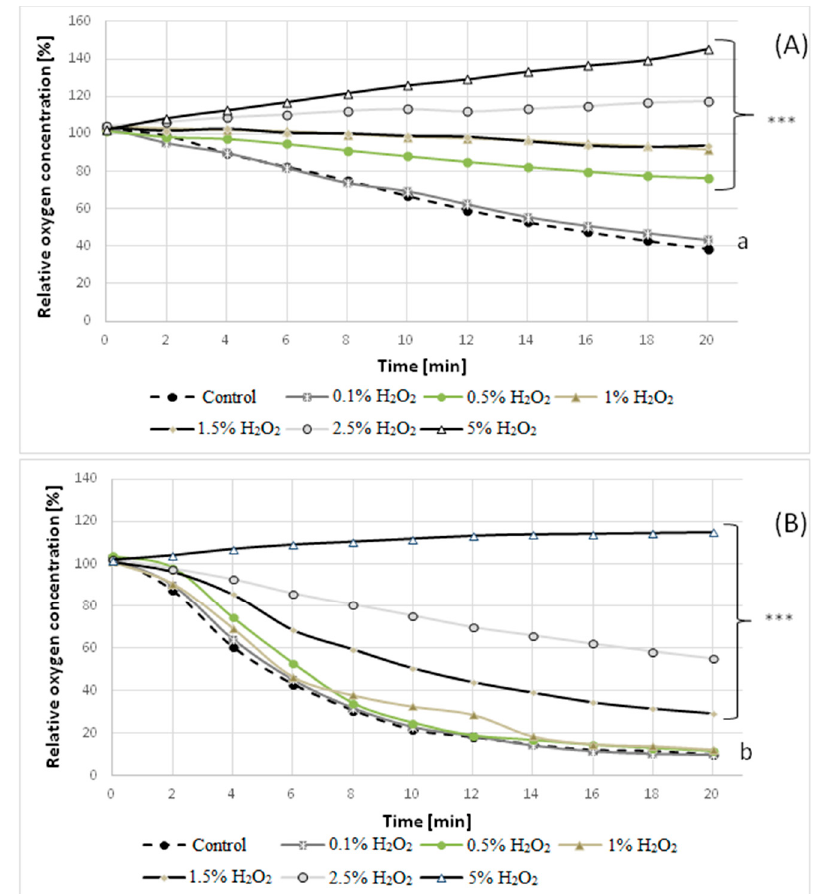
Figure 7 . Oxygen consumption rate by the mycelium of the wild strain ( A ) and mutant 1–6 ( B ) of C. pannorum A-1 pre-incubated with different concentrations of H 2 O 2 . ***( p < 0.0001) indicate statistically significant differences with respect to the control (mycelium incubated without the addition of H 2 O 2 ). Lowercase letters (a, b) indicate that the differences between control wild strain and the 1–6 mutant are significant ( p ≤ 0.0001).